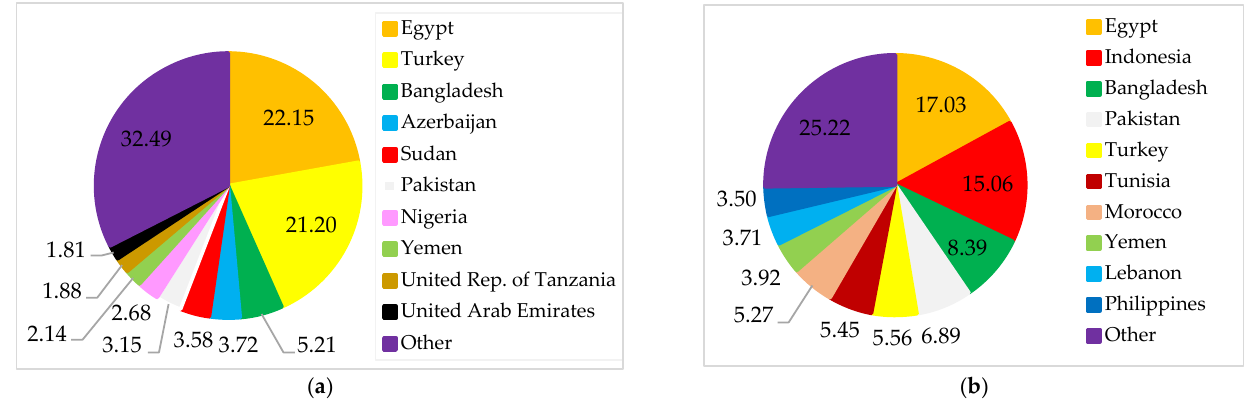
Figure 7. Destinations for Russian ( a ) and Ukrainian ( b ) wheat exports. Source: [30].